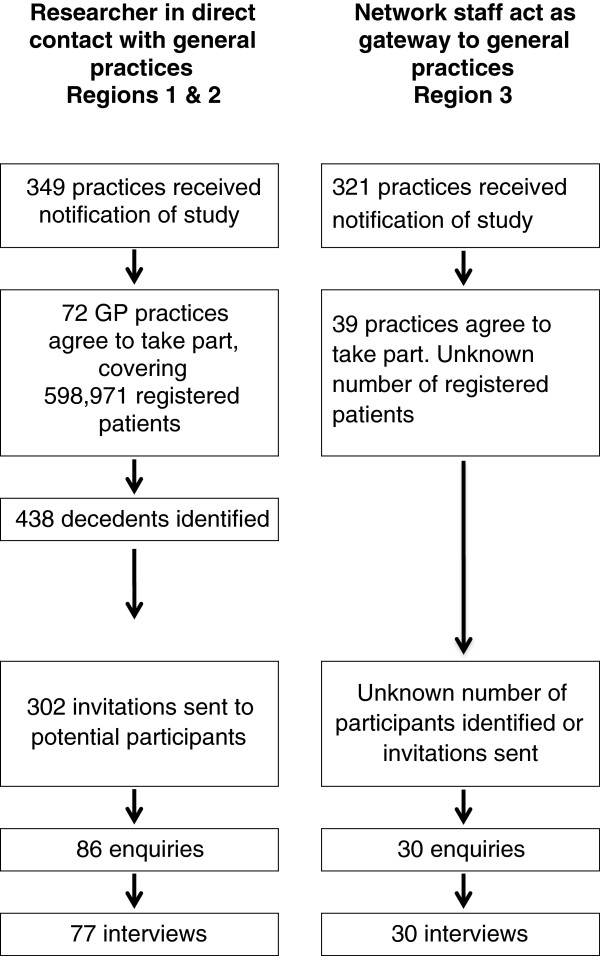
Recruitment of bereaved carersby general practices withresearch network support.